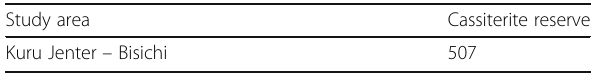
Table 5 Estimated cassiterite reserve in the study area (metric tonnes) Study area Cassiterite